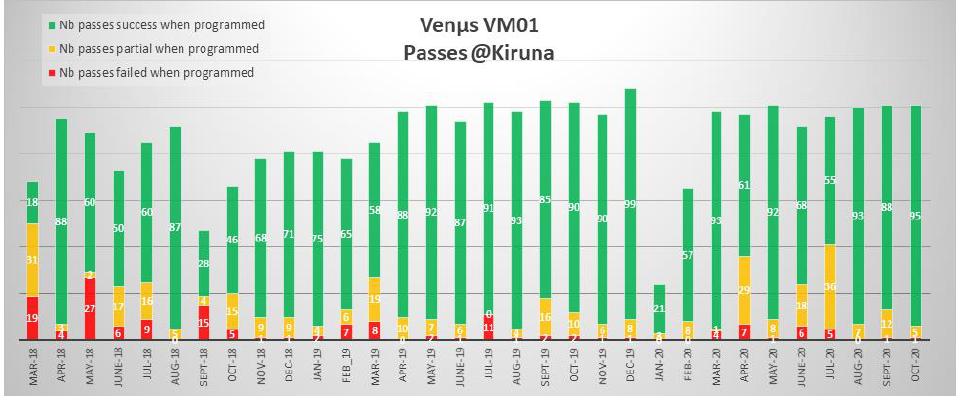
Figure 41. Statistics on Kiruna station passes.